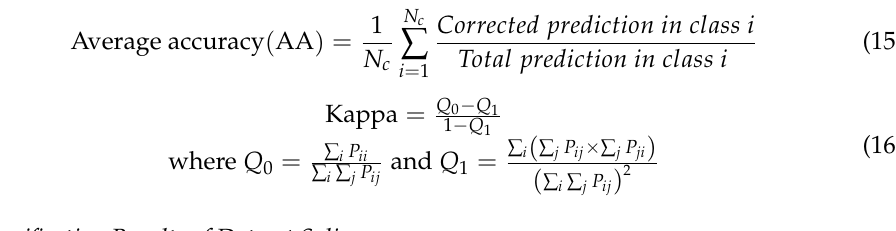
( a ) The overlapping degrees of various values α .